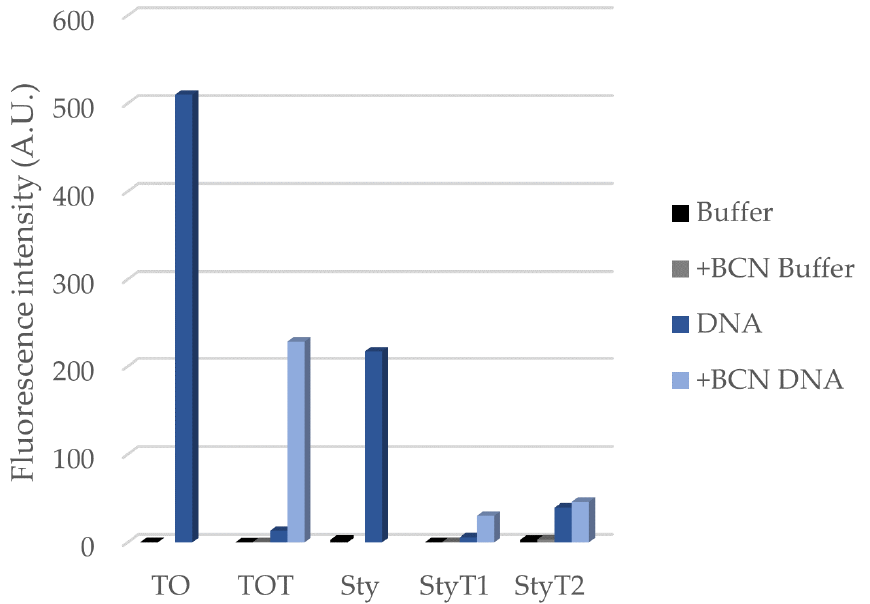
Figure 4. Fluorescence intensities of 1.0 µ M TO and Sty frames, their tetrazine modified derivatives, and the BCN conjugates of the tetrazines in the absence and presence of 0.4 mg/mL calf thymus dsDNA in TRIS–PBS 1:4 at 21 ◦ C. λ exc : 480 nm for unsubstituted TO and 490 nm for all of the other probes, the emission was recorded at the maxima. Table 2. Fluorescence quantum yields of TO and Sty frames, their tetrazine modified derivatives, and the BCN conjugates of the tetrazines in the absence and presence of DNA. +BCN +BCN Φ PBS Φ DNA Φ PBS Φ DNA TO 0.00029 - 0.30 - TOT N.D. a 0.0016 0.014 0.24 Sty 0.0031 - 0.19 - StyT1 0.00093 0.0024 0.014 0.072 StyT2 0.014 0.013 0.15